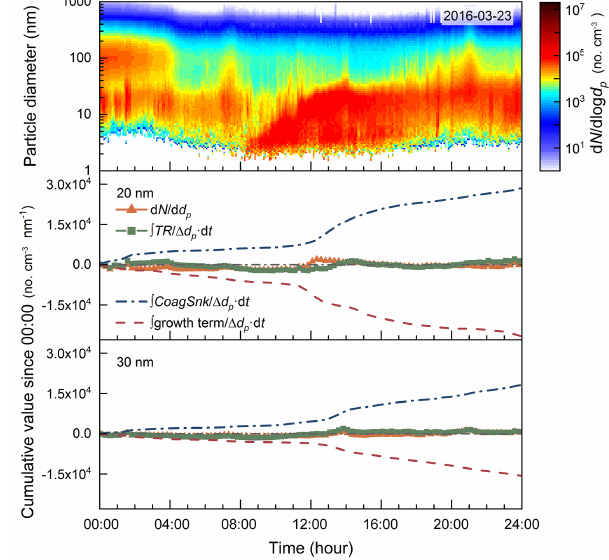
Figure 8. (a) The contour plot of aerosol size distributions of a typi- cal type-A new particle formation event observed on 2 March 2016, at the Fukue Island site. The dashed lines indicate the analyzed par- ticle diameters. (b) The time series of wind speed, wind direction, and water vapor mixing ratio. (c) The time series of the estimated cumulative transport terms for various sized particles.